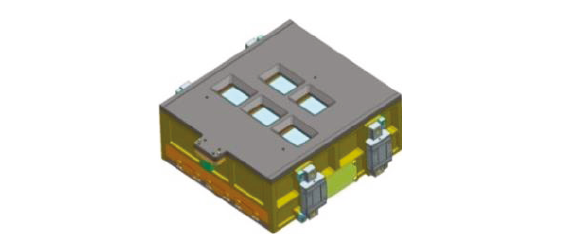
Figure 2: The focal plane electric box.